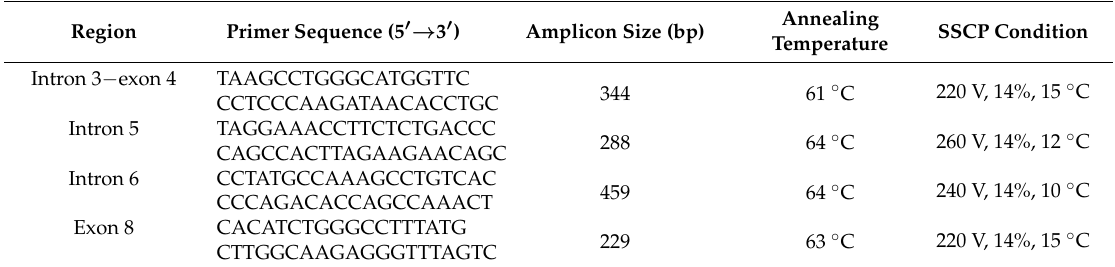
Table 1. PCR primers sequences and SSCP conditions for yak DGAT2